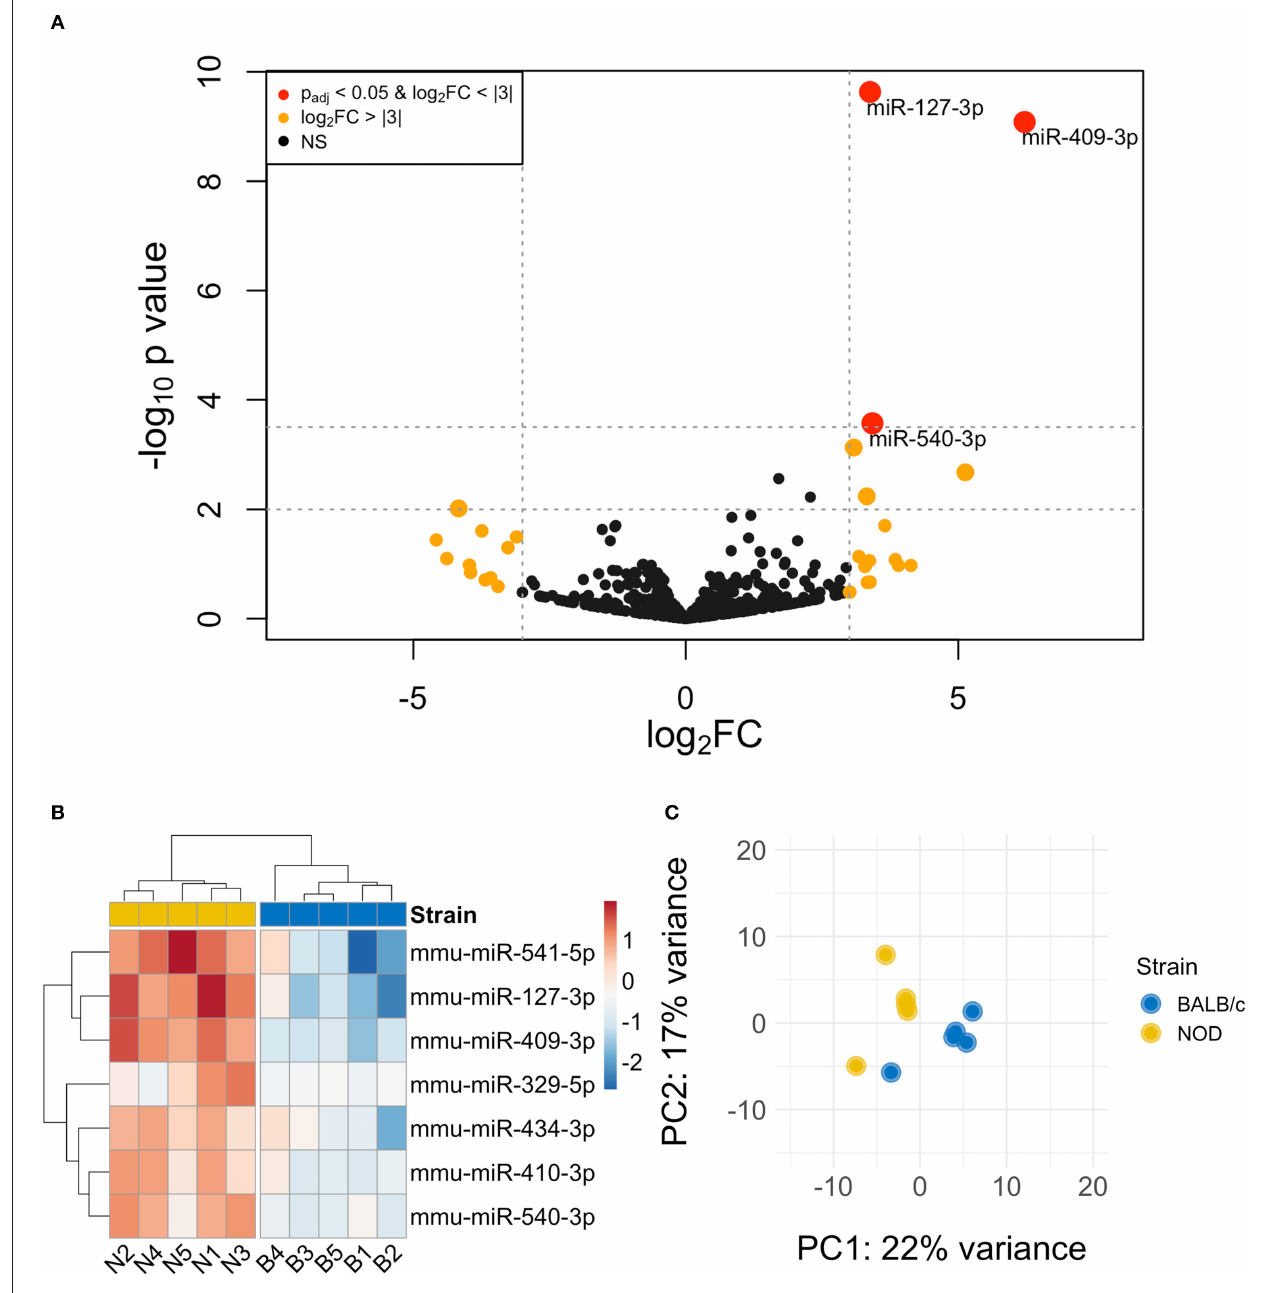
FIGURE 3 | Differential miRNA expression analysis. (A) The volcano plot highlights miRNAs that were identified in exosomes isolated by differential ultracentrifugation as upregulated or downregulated by more than 3-fold, shown in orange. Upregulated miRNAs that are statistically significantly different are shown in red. (B) Unsupervised hierarchically clustered heatmaps of the most differentially expressed miRNA (with highly expressed miRNAs in red and minimally expressed miRNAs in blue) in the 10 samples. Samples are labeled either N for NOD or B for BALB/c. Individual samples for the top differentially expressed miRNA cluster by strain. (C) PCA plot of all miRNAs shows that 22% of the variance was accounted for by